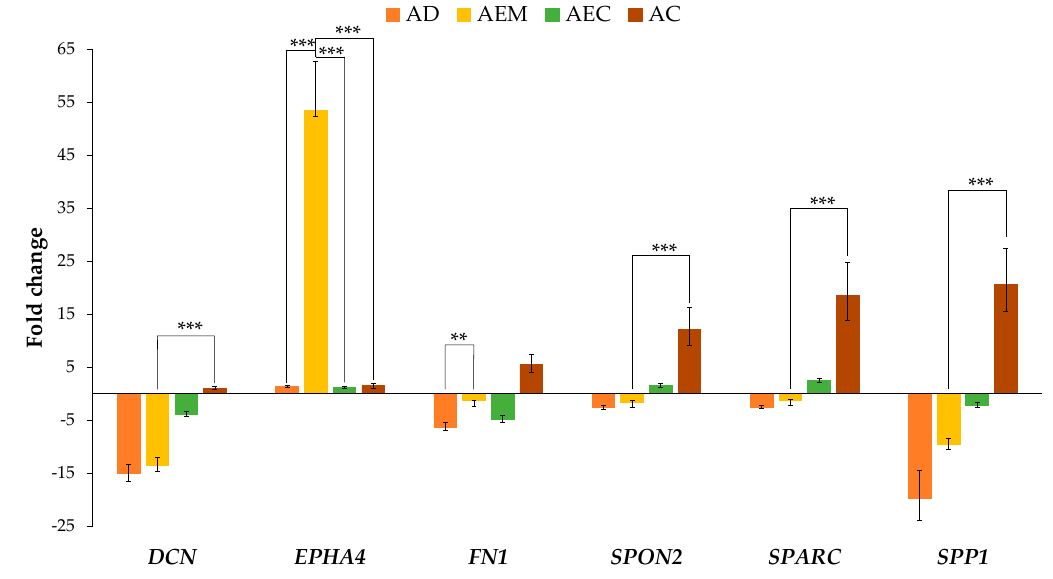
Figure 1. Expression of DCN , EPHA4 , FN1 , SPON2 , SPARC and SPP1 in adenoma, adenoma with